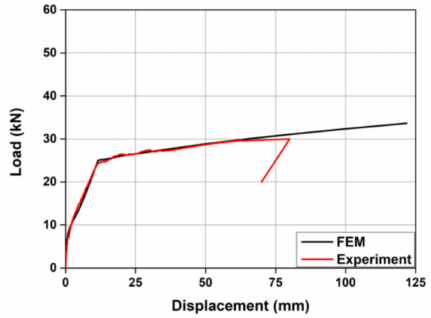
Figure 7. Comparison of load-displacement curves for SL-CTRL.